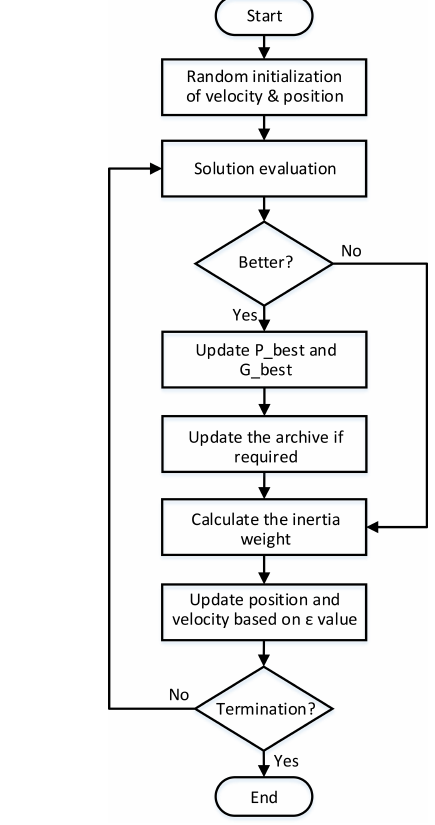
Figure 4. Flow diagram of the proposed ERPSO algorithm.